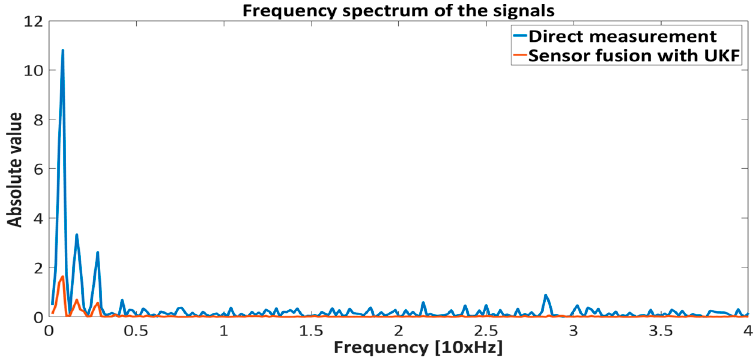
Figure 18. Frequency spectrum of the proximity measurements (direct measurement and sensor fusion)